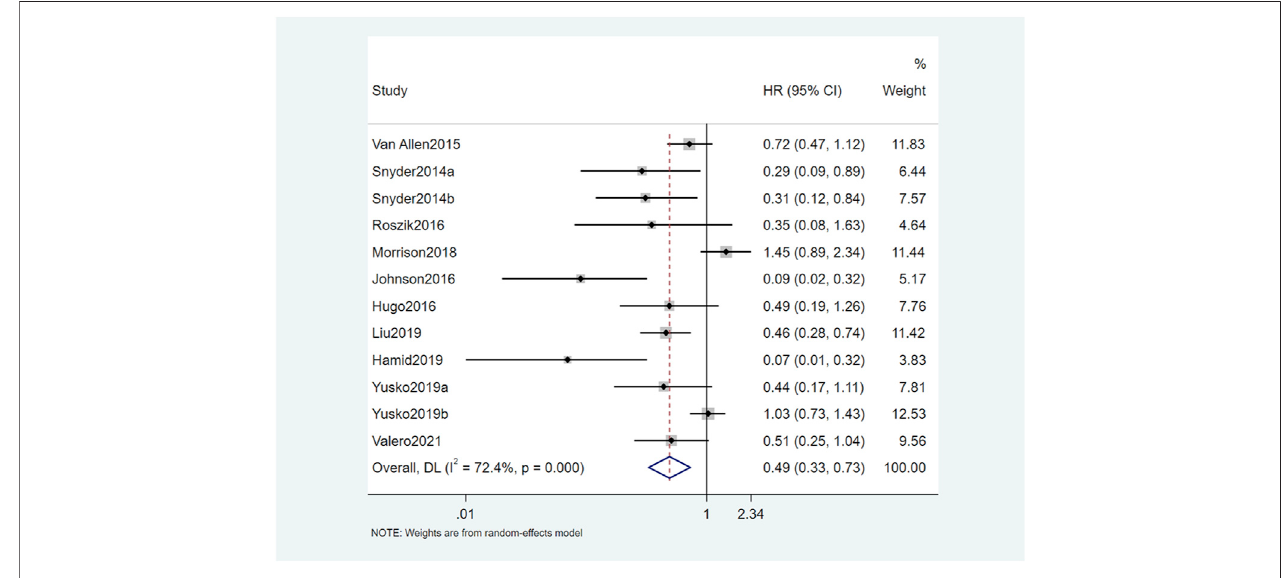
FIGURE 2 | Forest plot of association between TMB and OS.